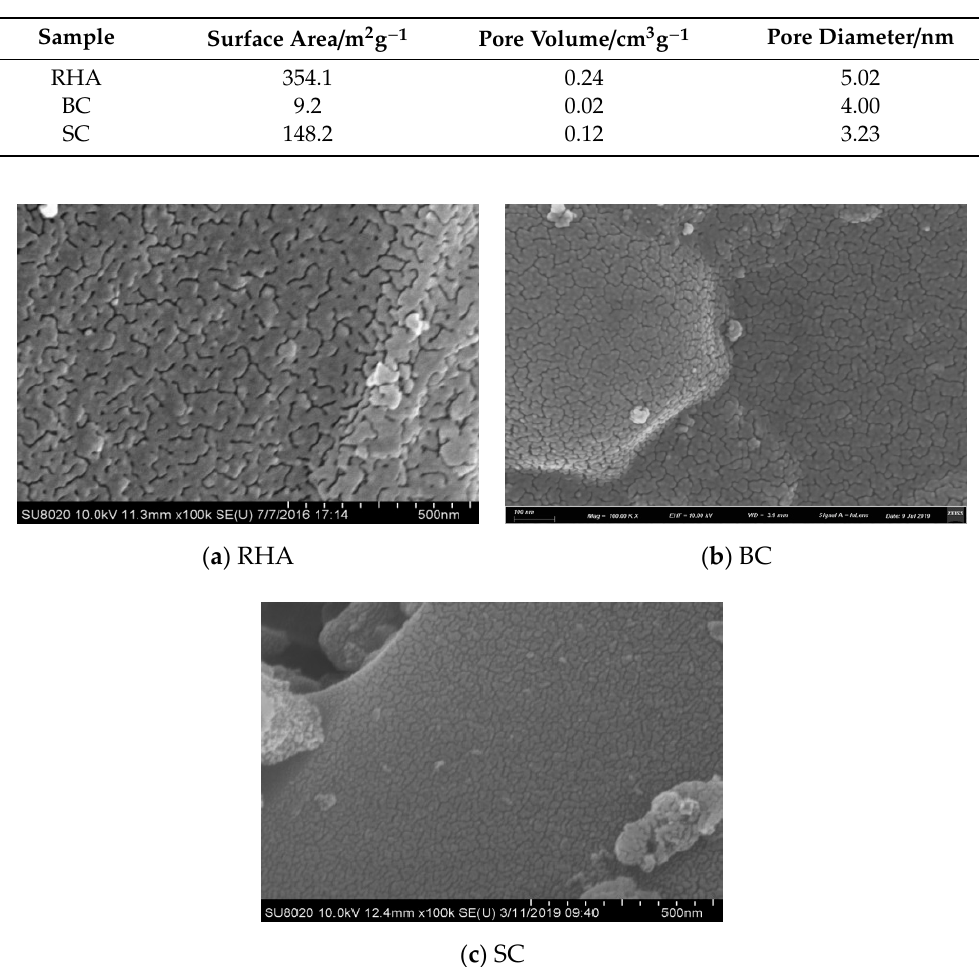
Figure 2. SEM images of ( a ) RHA, ( b ) BC, ( c ) SC. The magnification for all samples is 100 k.